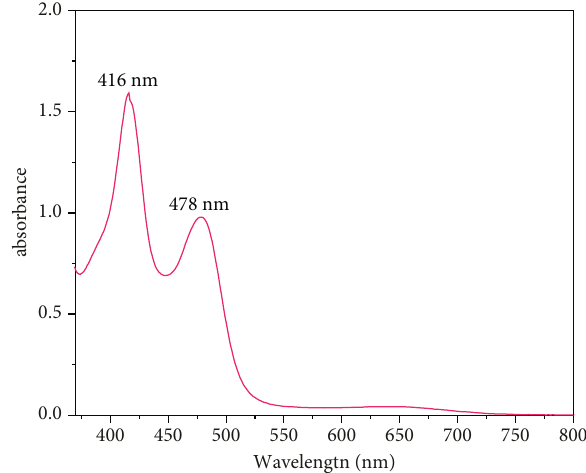
Figure 2: UV-Vis absorbance of the NiEtX complex.